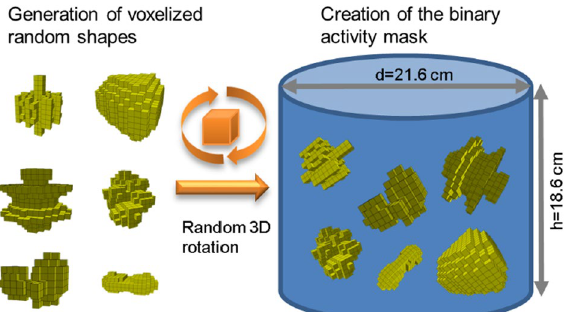
Fig. 2 Illustration of the creation of the binary activity masks. For each binary activity mask, a set of random shapes of different sizes is generated. Afterwards, a random 3D rotation is performed for each shape and it is placed at a random location inside the Jaszczak phantom